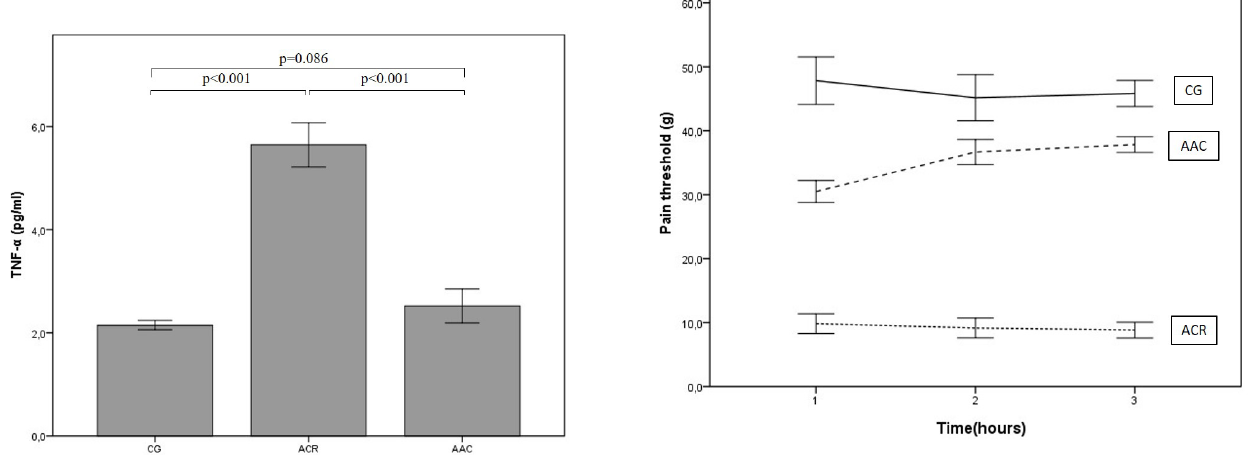
FIGURE 5 - Comparison of the TNF-α levels between the study groups. Bars represent mean ± standard deviation. CG control group, ACR acrylamide-treated group, AAC anakinra + acrylamide-treated group.